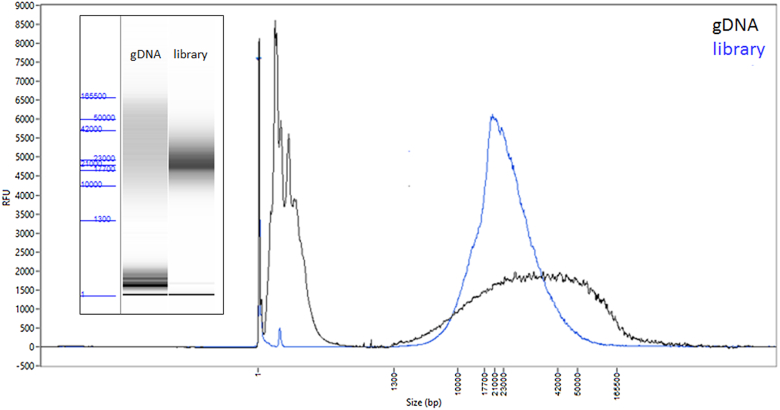

Lycorma delicatula input DNA and resulting library. FEMTO Pulse traces and “gel” images (inset) of the genomic DNA (gDNA) input (black) and the final library (blue) before sequencing.